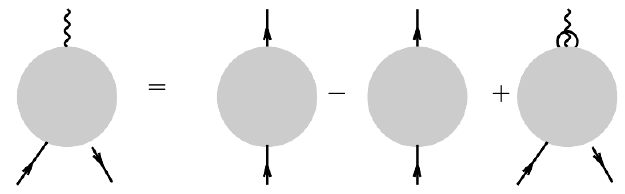
Figure 2 . The WI for the vertex function of (5.3) where the last term is the extra term due to the C